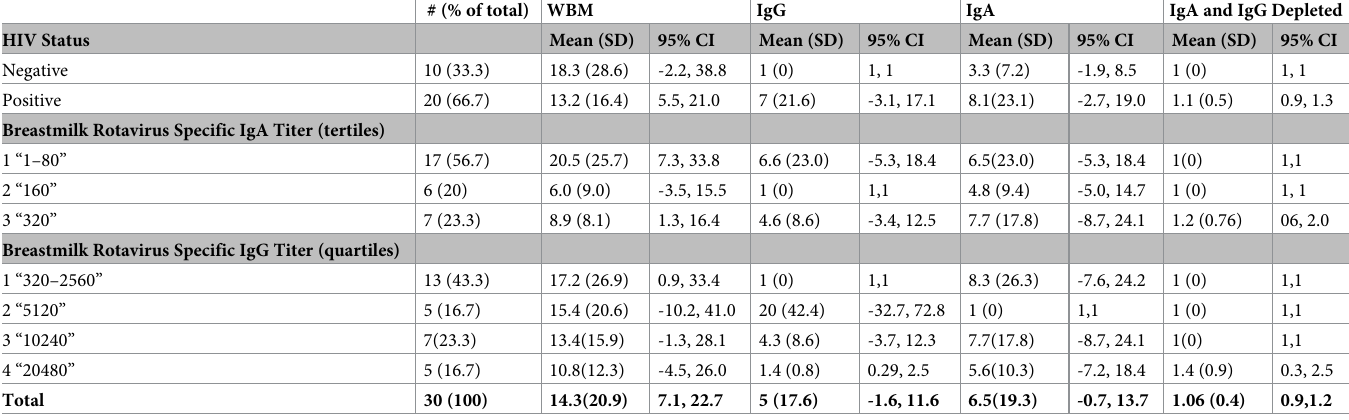
Table 1. 50% Inhibitory dilution (ID50) Mean breastmilk samples titers (Whole breastmilk (WBM), purified IgG, purified IgA, and IgA and IgG depleted breast- milk) by mother’s